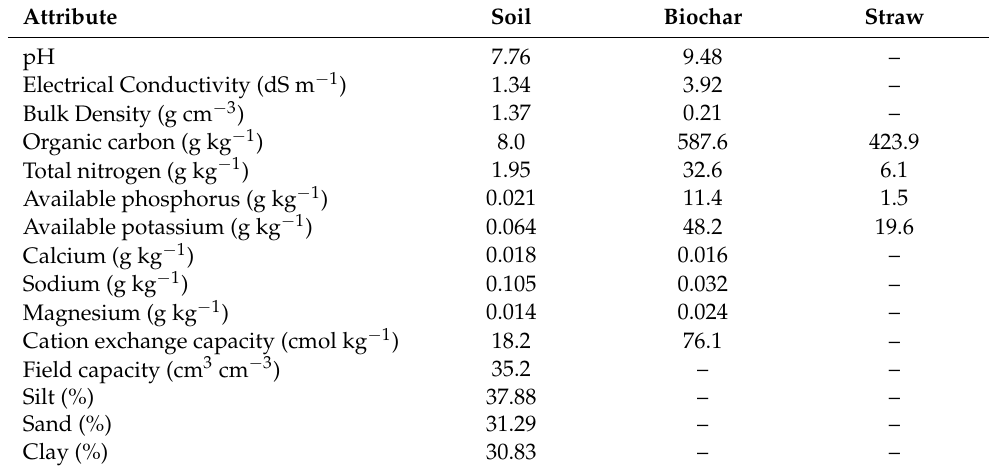
Table 1. Physical and chemical properties of the initially tested soil (0–15 cm), the biochar, and the